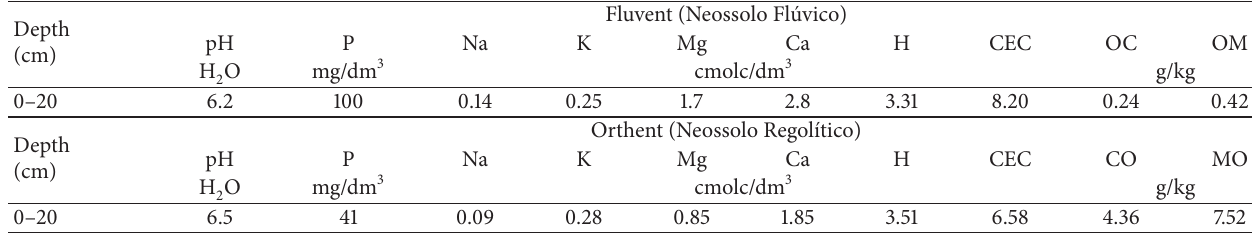
Table 2: General chemical properties of the soils studied.